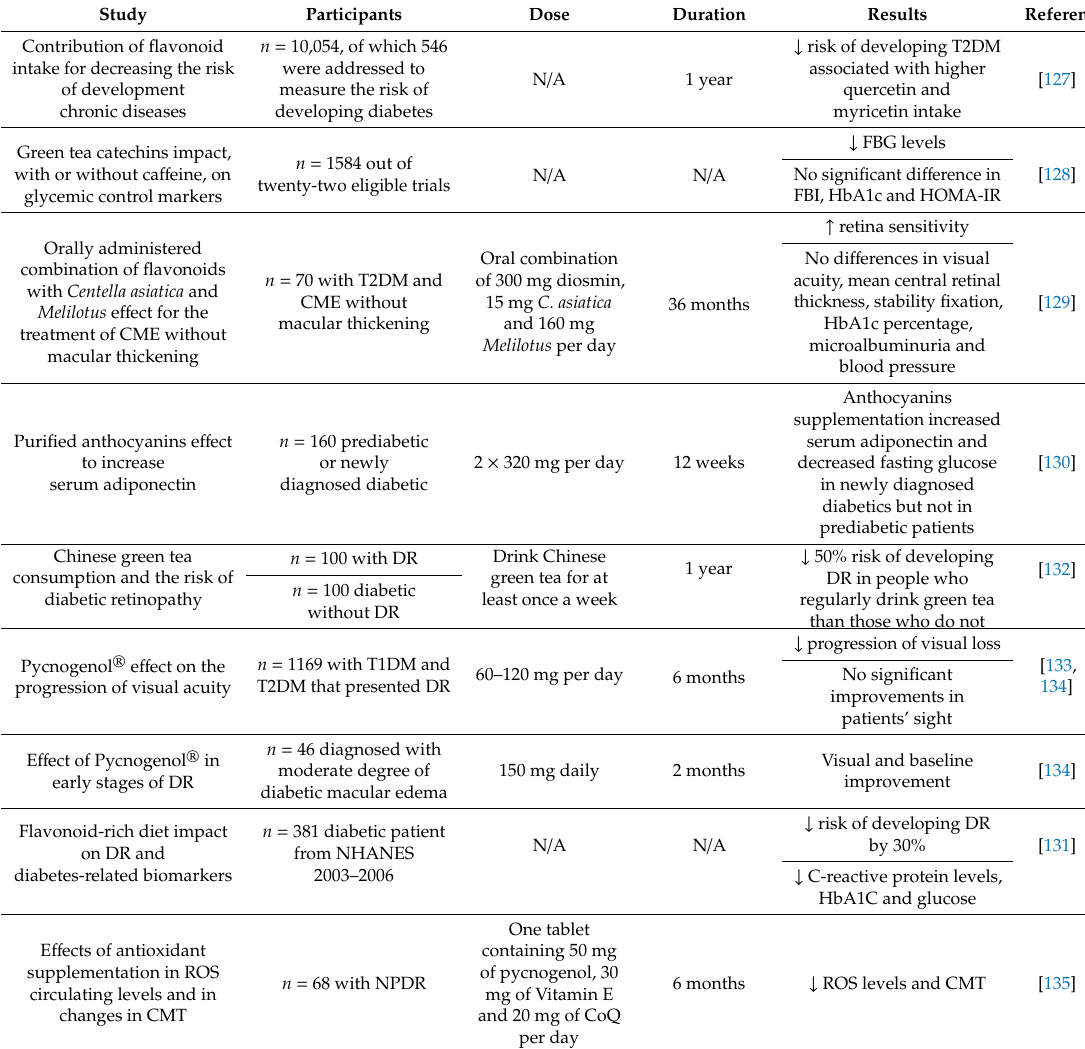
Table 7. Clinical studies with flavonoids e ff ect in diabetes and diabetic retinopathy (DR).